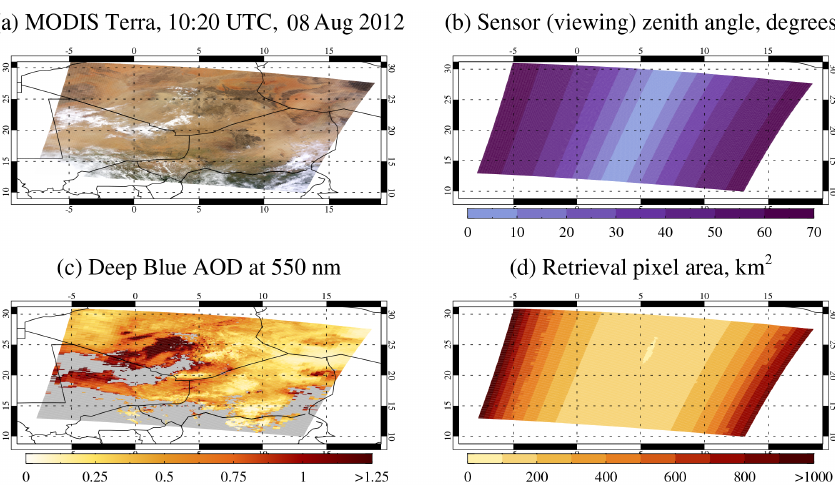
Figure 2. MODIS granule used as a case study throughout this manuscript. Panel (a) shows a true-colour composite, (b) the VZA along and across the scans, (c) the L2 (nominal 10km) Deep Blue retrieved AOD for the granule, and (d) the Deep Blue retrieval-pixel area.